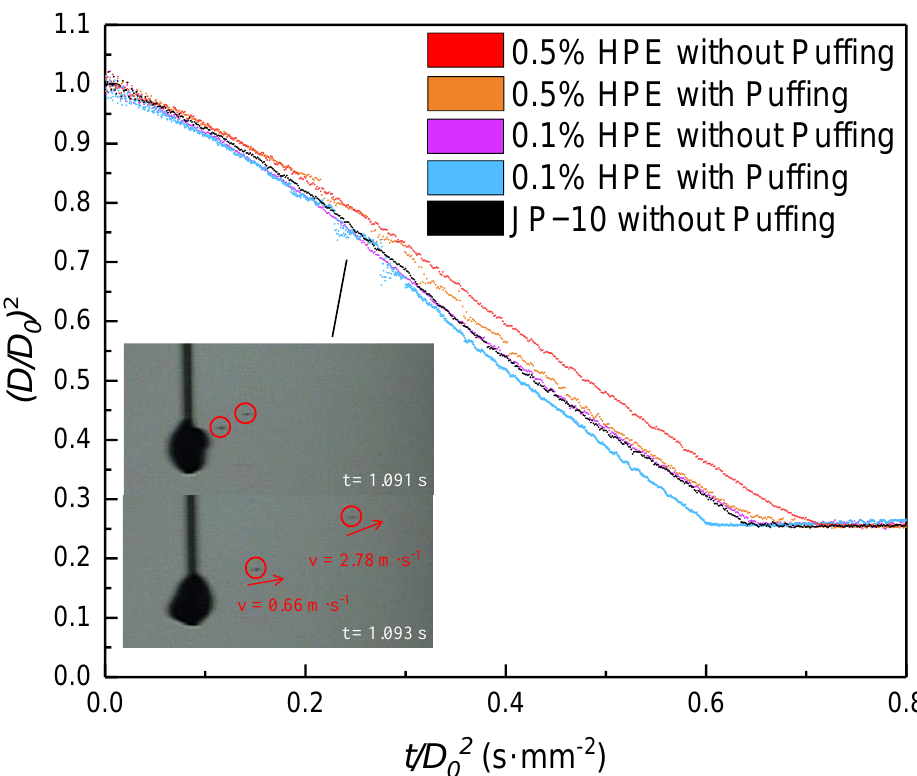
Figure 8. Evolution of droplet diameter square for JP-10 droplets blended with different mass concentrations of HPE at 800 K.